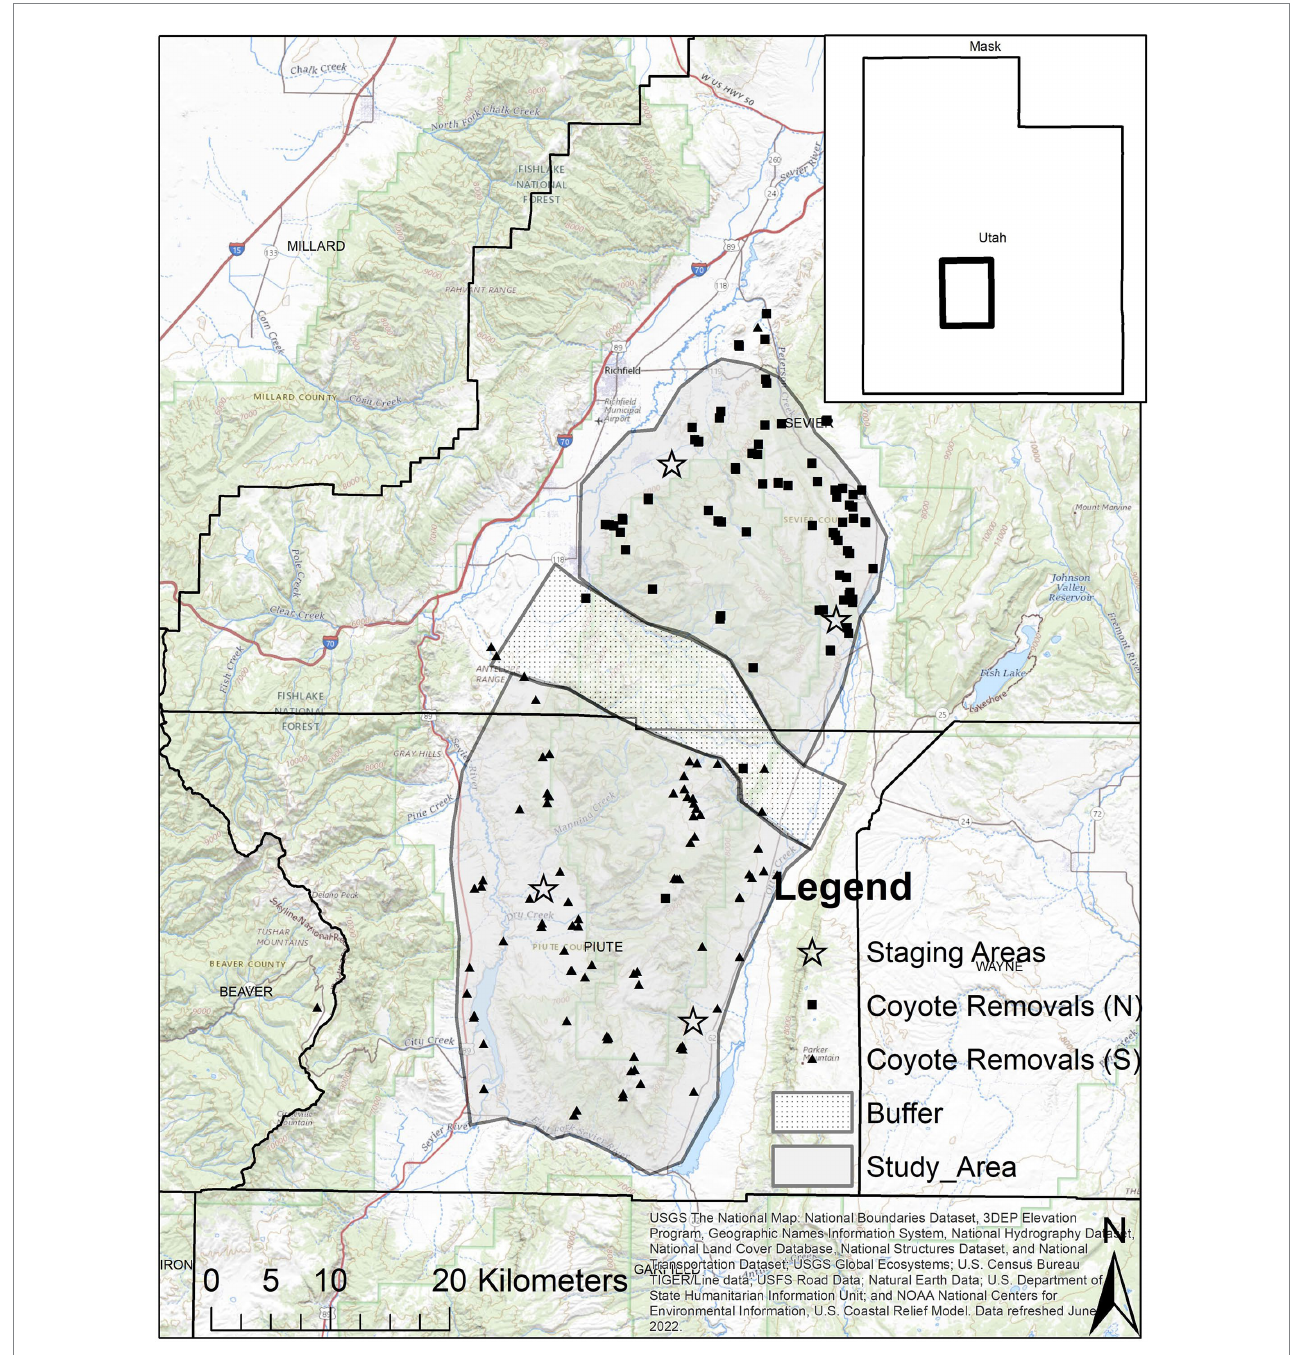
FIGURE 1 Map of Monroe Mountain, Utah, United States with polygons delineating north (coyote removal area 2012–2013) and south (coyote removal area 2014– 2015) study areas where we evaluated survival of neonate mule deer. The stippled area indicates the buffer zone between the two study areas and was bordered on the north and south by deep canyons that traversed the mountain. Squares and triangles indicate the location of coyotes that were removed from the mountain during 2012–2013 and 2014–2015, respectively. Stars represent the centroid of areas on winter range where adult females were captured each March of the